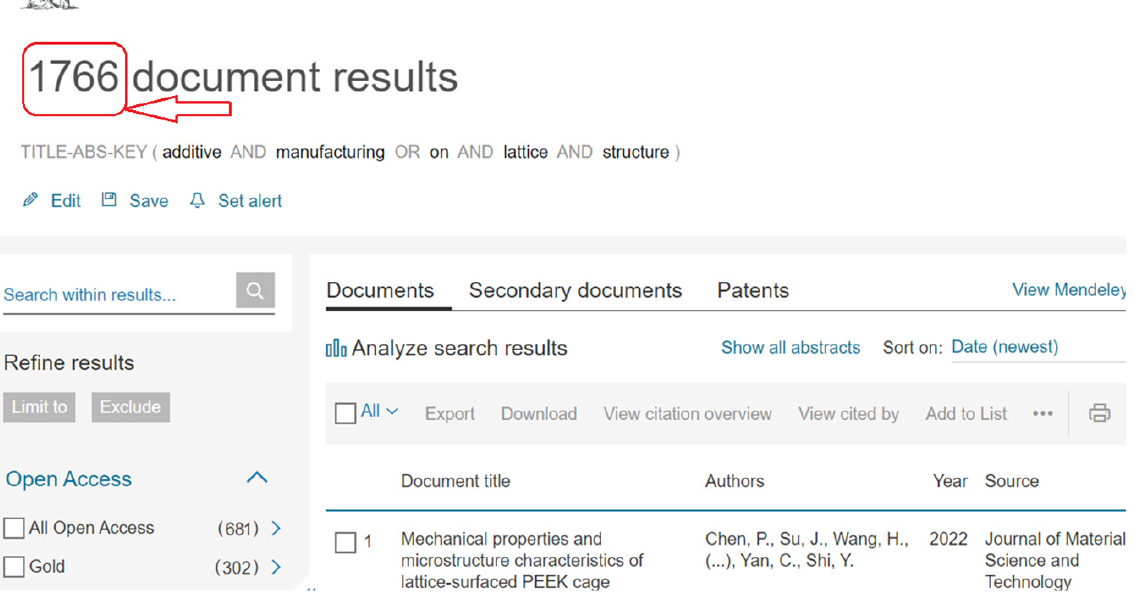
Figure 3. Scopus database supplied by Lancaster University UK, showing keyword “additive manufacturing on lattice structures” for meta-analysis (on 20 June 2022).